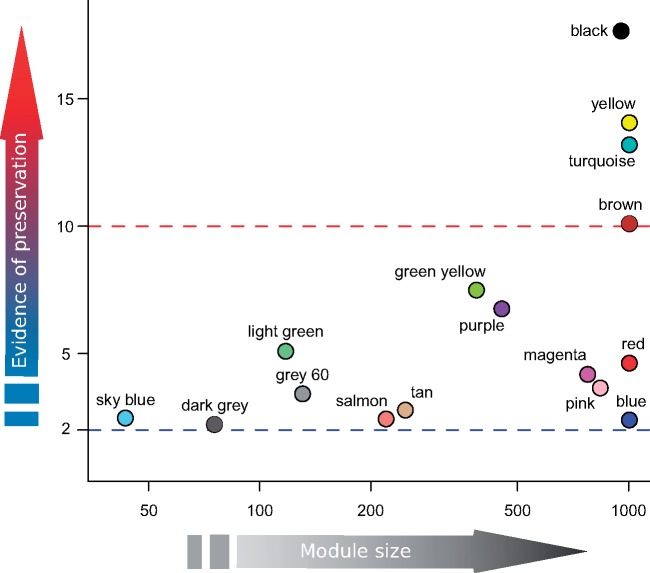
—Plot of module preservation versus module size. Module preservation is expressed using the Zsummary statistic, module size is the number of transcripts belonging to a given module. The Zsummary statistic quantifies the level of preservation of the modules of the 1 mph coexpression network in the 1 dph coexpression network, therefore, the color names refer to the colors of the 1 mph network (supplementary figure S3, Supplementary Material online). The blue line indicates the threshold (Zsummary=2) below which there is no evidence of preservation, whereas the red line indicates the threshold (Zsummary=10) above which there is strong evidence of preservation. The modules with Zsummary<2 have been removed from this figure, but a complete version of the plot can be found in supplementary figure S14, Supplementary Material online.